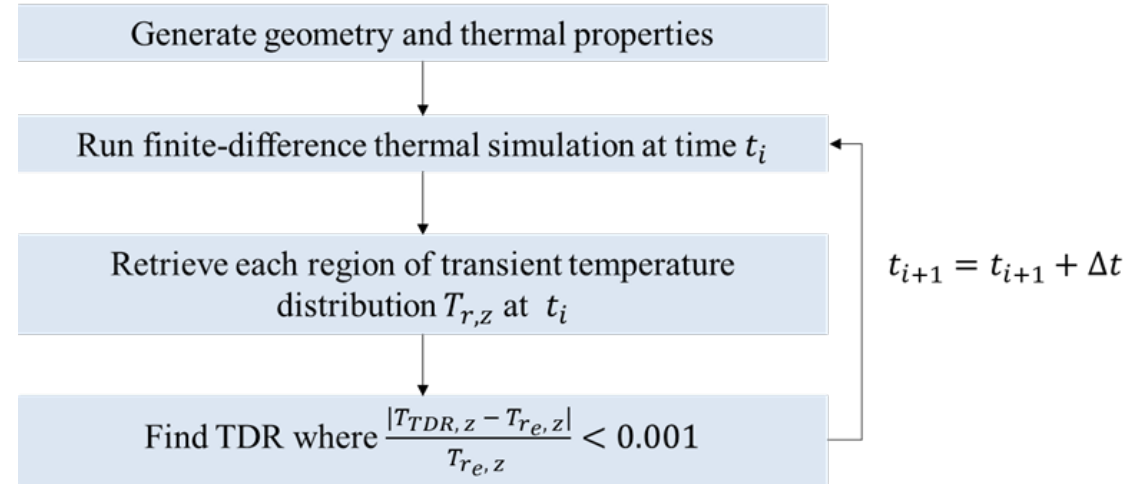
Figure 3. The flow chart of calculation.